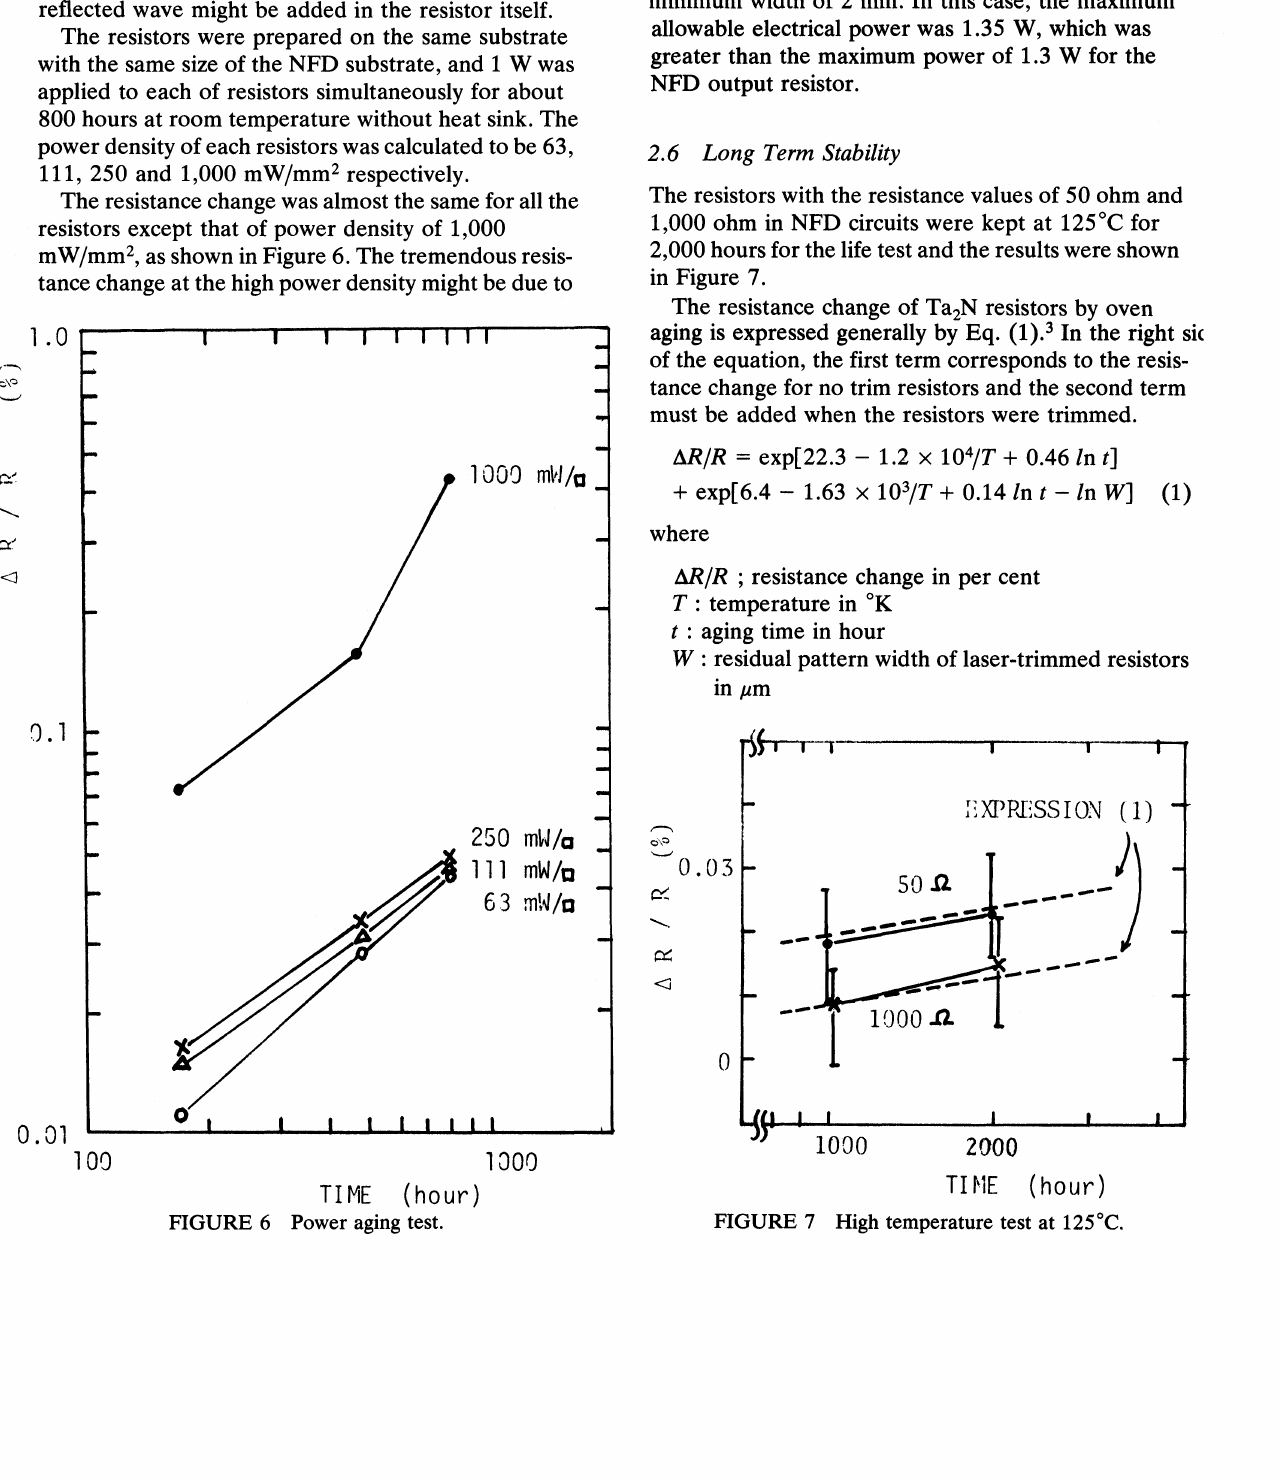
FIGURE 6 Power aging test. FIGURE 7 High temperature test at